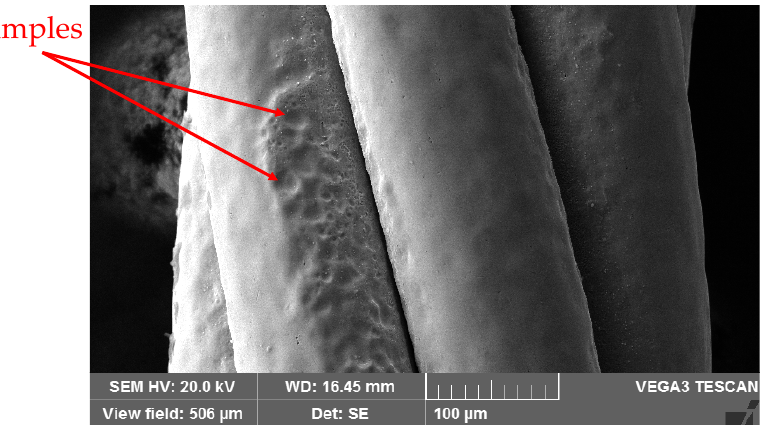
Figure 21. SEM image showing dimples on the surface of the NiTi SMA micro cable which contribute to a lower structural fatigue life.